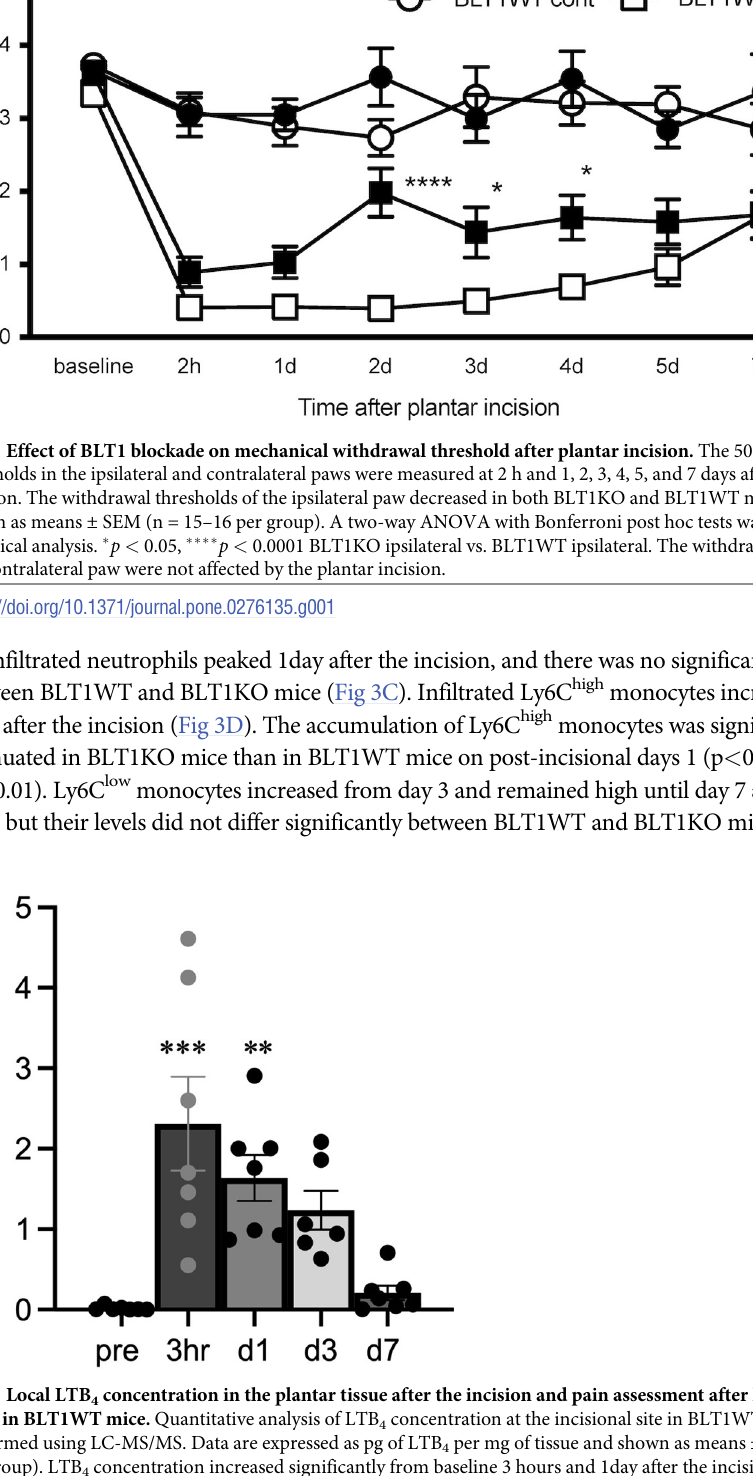
Fig 2. Local LTB 4 concentration in the plantar tissue after the incision and pain assessment after local injection of LTB 4 in BLT1WT mice. Quantitative analysis of LTB 4 concentration at the incisional site in BLT1WT mice was performed using LC-MS/MS. Data are expressed as pg of LTB 4 per mg of tissue and shown as means ± SEM (n = 6–7 per group). LTB 4 concentration increased significantly from baseline 3 hours and 1day after the incision. A one-way ANOVA with Bonferroni post hoc tests was used for statistical analysis. ��� p < 0.001, �� p < 0.01 vs.